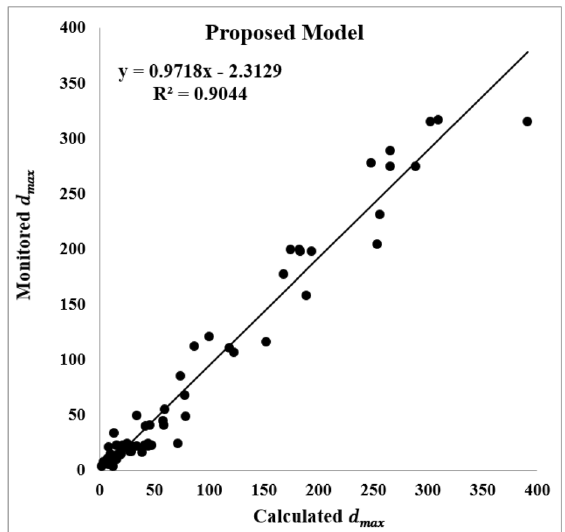
2 Figure 16. R derived from testing the proposed model by unseen actual